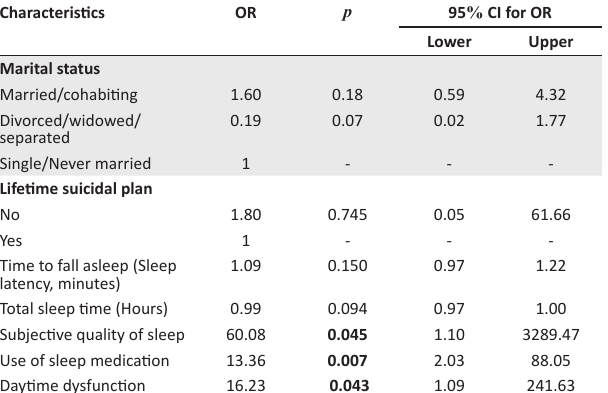
TABLE 3 : Binary logistic regression analysis to determine factors independently associated with poor sleep quality in euthymic bipolar disorder patients. Characteristics